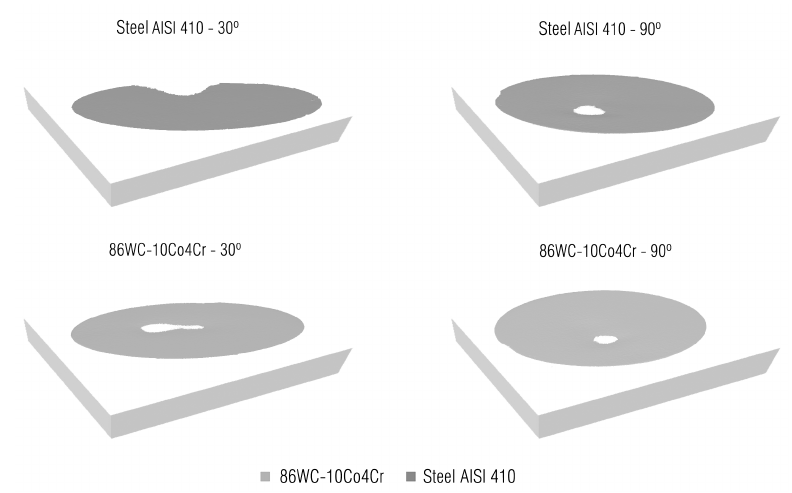
Figure 12. Three-dimensional scanning of the samples submitted to the jet slurry erosion test obtained the eroded depth by using the Geomagic Studio software (Version 2012.1.1, 3D Systems Inc, Rock Hill, SC, USA). Table 7. Average depth of the eroded regions for substrate and